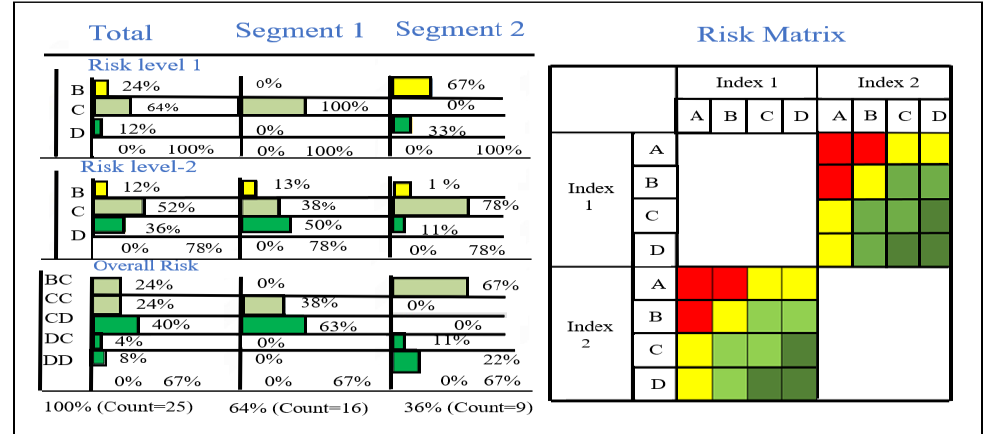
Figure 7. Results of latent class analysis with two segments and 25 samples.